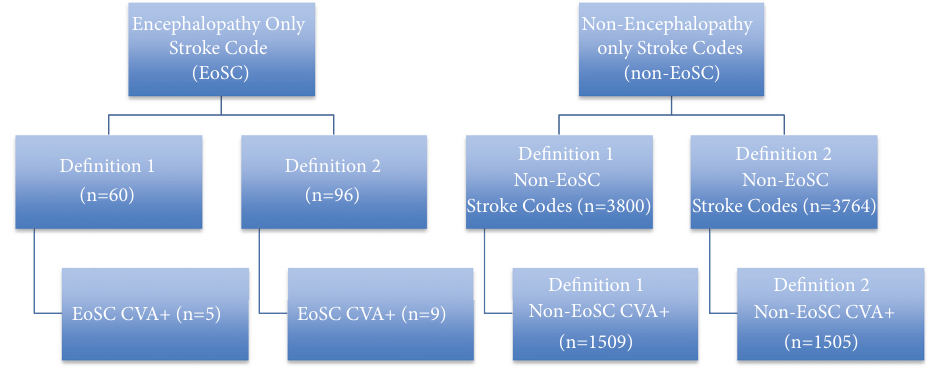
Figure 1: Study Definitions . Schematic showing study definitions. Stroke codes are first defined as encephalopathy only (EoSC) or other stroke codes (non-EoSC). EoSC were put into two different definitions based on NIHSS: one with only mental status changes (Definition 1) and another allowing for symmetric motor findings (Definition 2). Under each definition there is a final diagnosis of stroke (EoSC CVA+) which is compared to non-EoSC stroke positive diagnoses (non-EoSC